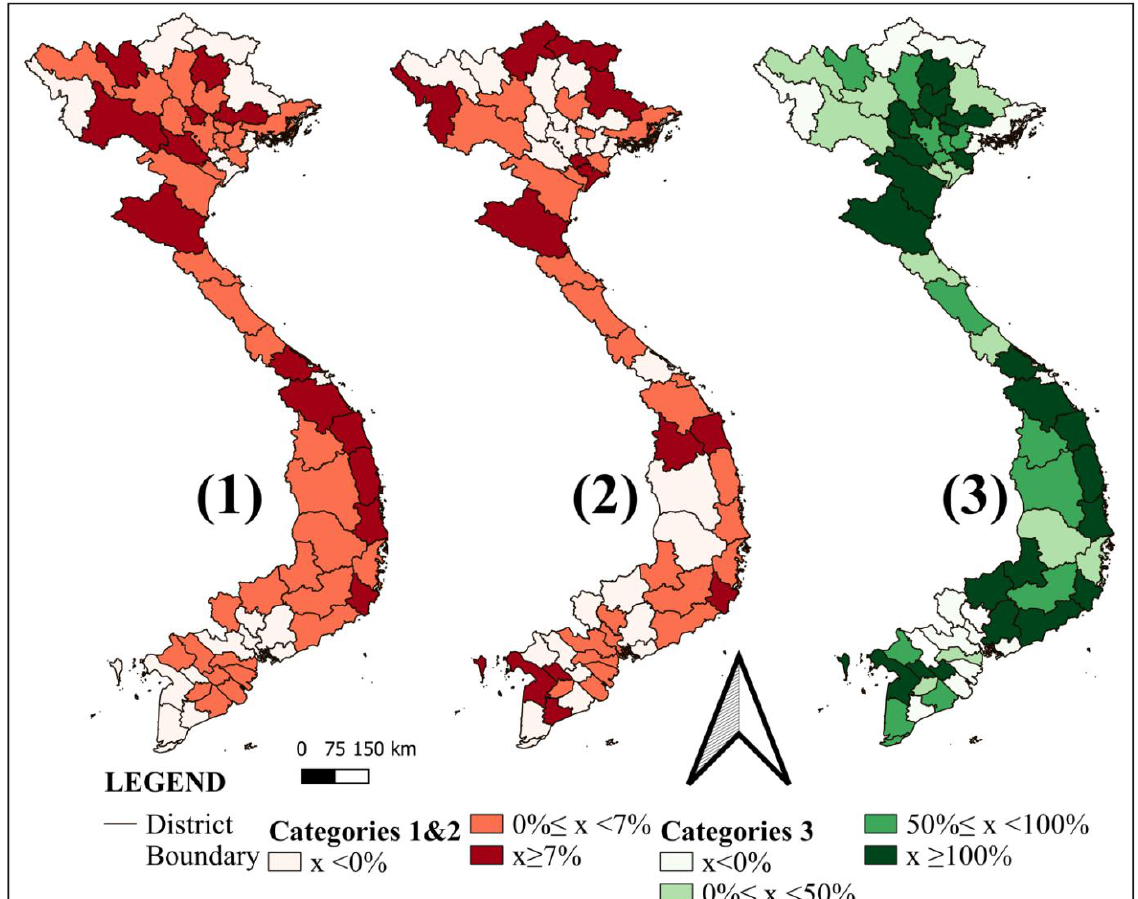
Fig. 5. Changes in land use area by provinces using statistics from the MoNRE (2011–2018) (Source: Author’s complication from MoNRE): (1) – Agricultural land growth; (2) – Non-agricultural land growth; (3): Unused land